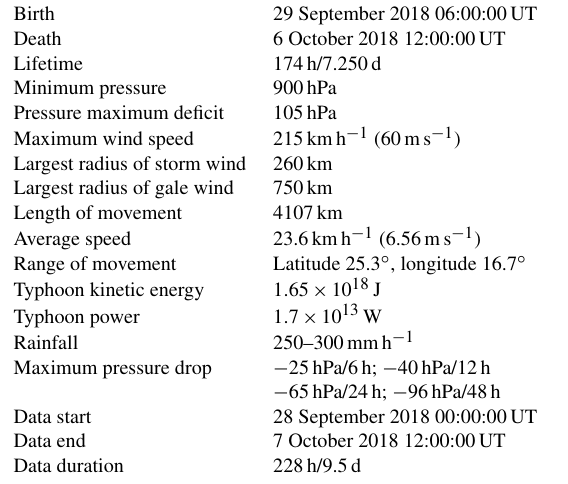
Table 1. Basic parameters of Typhoon Kong-rey (courtesy of Asanobu Kitamoto, Digital Typhoon, National Institute of Informat- ics,